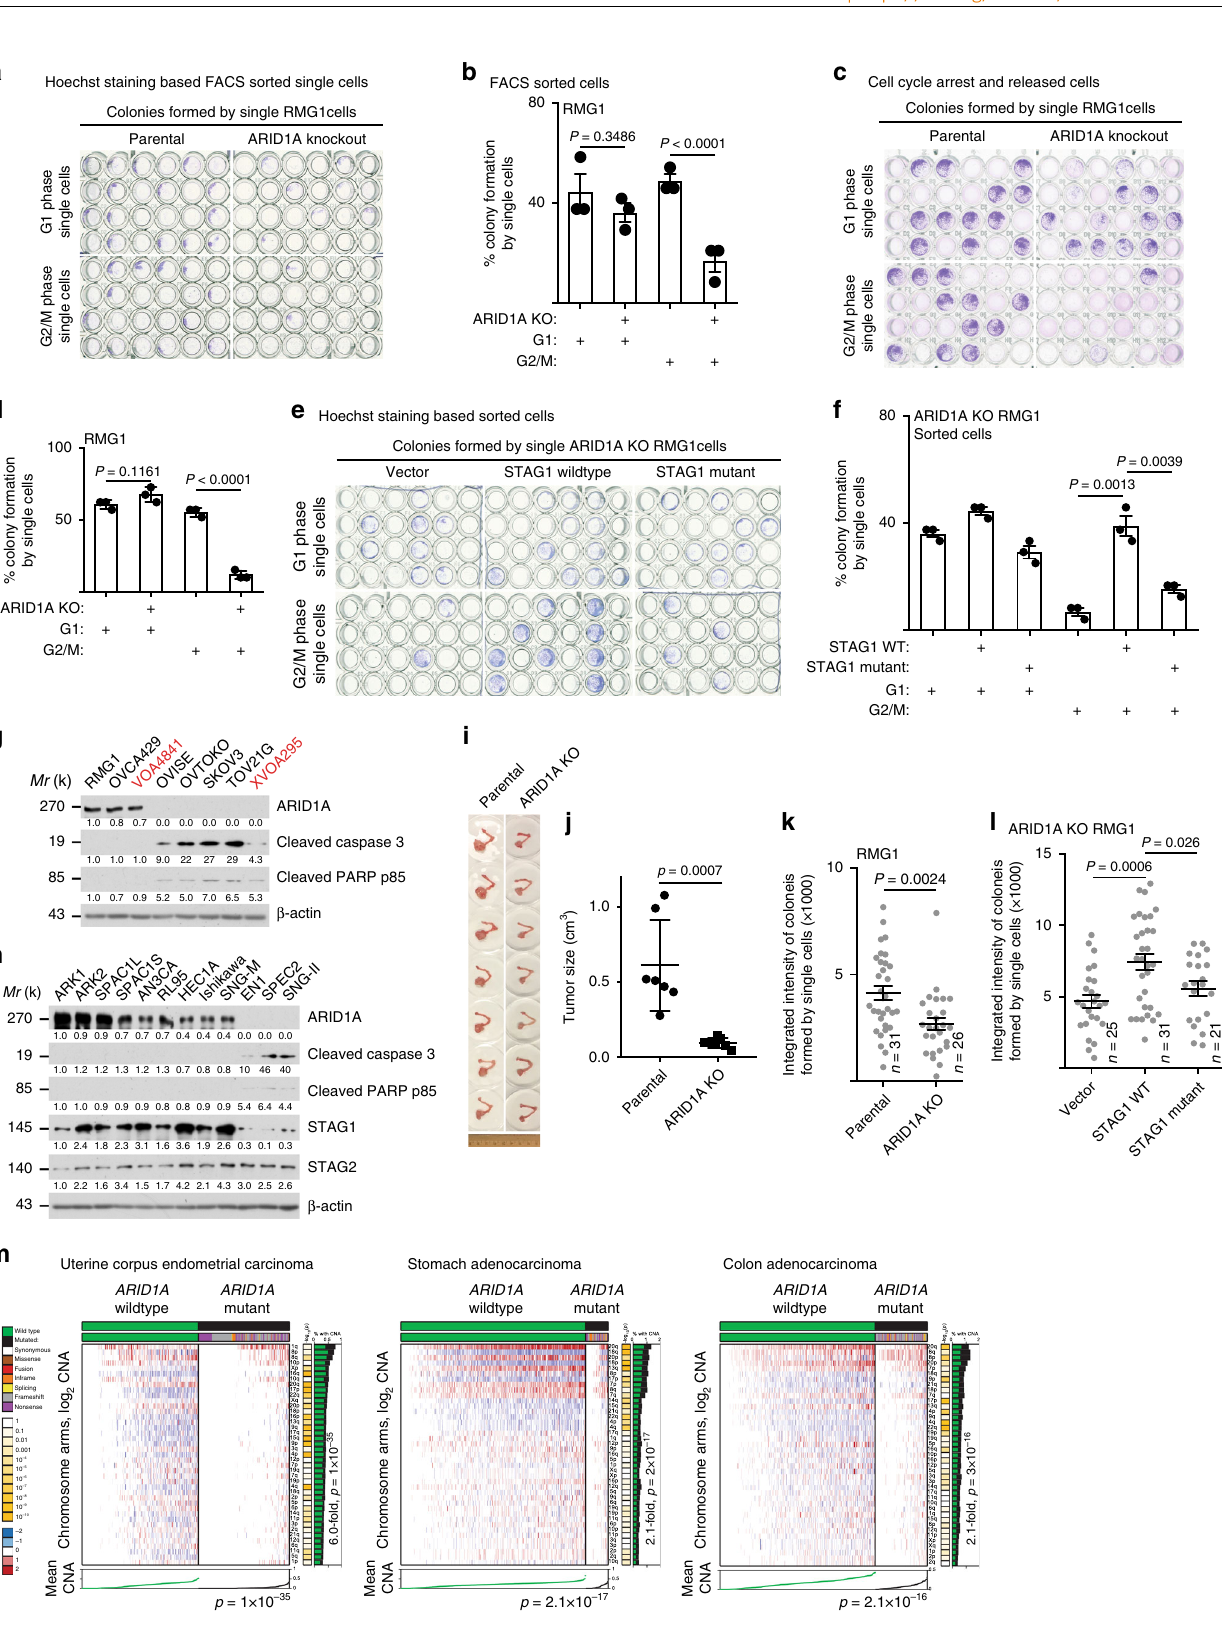
serum, Antibodies, Inc., Cat. no. 15-235-0001, 1:200 for immuno fl uorescence), mouse anti-FLAG tag (Sigma, Cat. no. F1804, 1:1000 for immunoblotting), rabbit anti-GFP tag (ThermoFisher, Cat. no. MA5-15256, 1:1000 for immuno- blotting, and 1:500 for immuno fl uorescence), rabbit anti-cleaved PARP p85 (Promega, Cat. no. G7341, 1:1000 for immunoblotting), rabbit anti-cleaved caspase